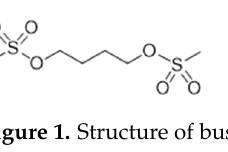
The reductive depolymerization of P4HB was initially carried out in the presence of 2 mol% of MoO 2 Cl 2 (H 2 O) 2 using 1 or 3 equivalents of PMHS in toluene at reflux temperature for 24 h. These reactions led to the formation of 1,4-butanediol with 39% and 59% yields, respectively (Table 1, entries 1 and 2). When the reaction was carried out in the presence of 5 mol% of catalyst and 3 equiv. of PMHS, the yield of 1,4-butanediol increased slightly to 63% (Table 1, entry 3). The depolymerization of P4HB was also studied using (EtO) 2 MeSiH (3 equiv.) as the reducing agent and MoO 2 Cl 2 (H 2 O) 2 (2 mol%) as the catalyst, producing 1,4-butanediol with 50% yield after 24 h at reflux temperature (Table 1, entry 4). This diol was also obtained in the 55% yield from the reaction of P4HB with PhSiH 3 (3 equiv.) in the presence of 5 mol% of MoO 2 Cl 2 (H 2 O) 2 (Table 1, entry 5).